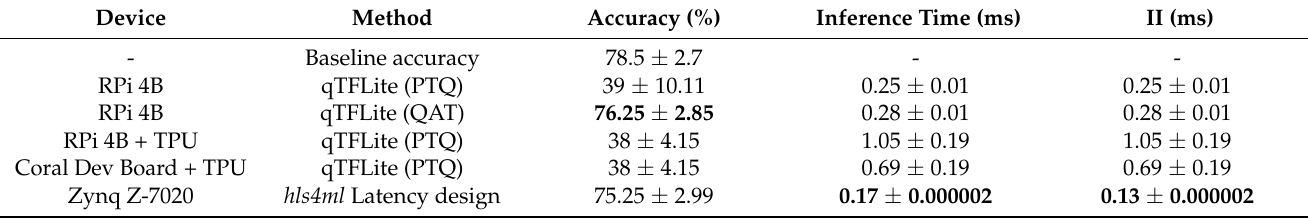
Table 9. CNN1D: Zynq Z-7020 vs. other embedded devices for the ESC-10 dataset. Device